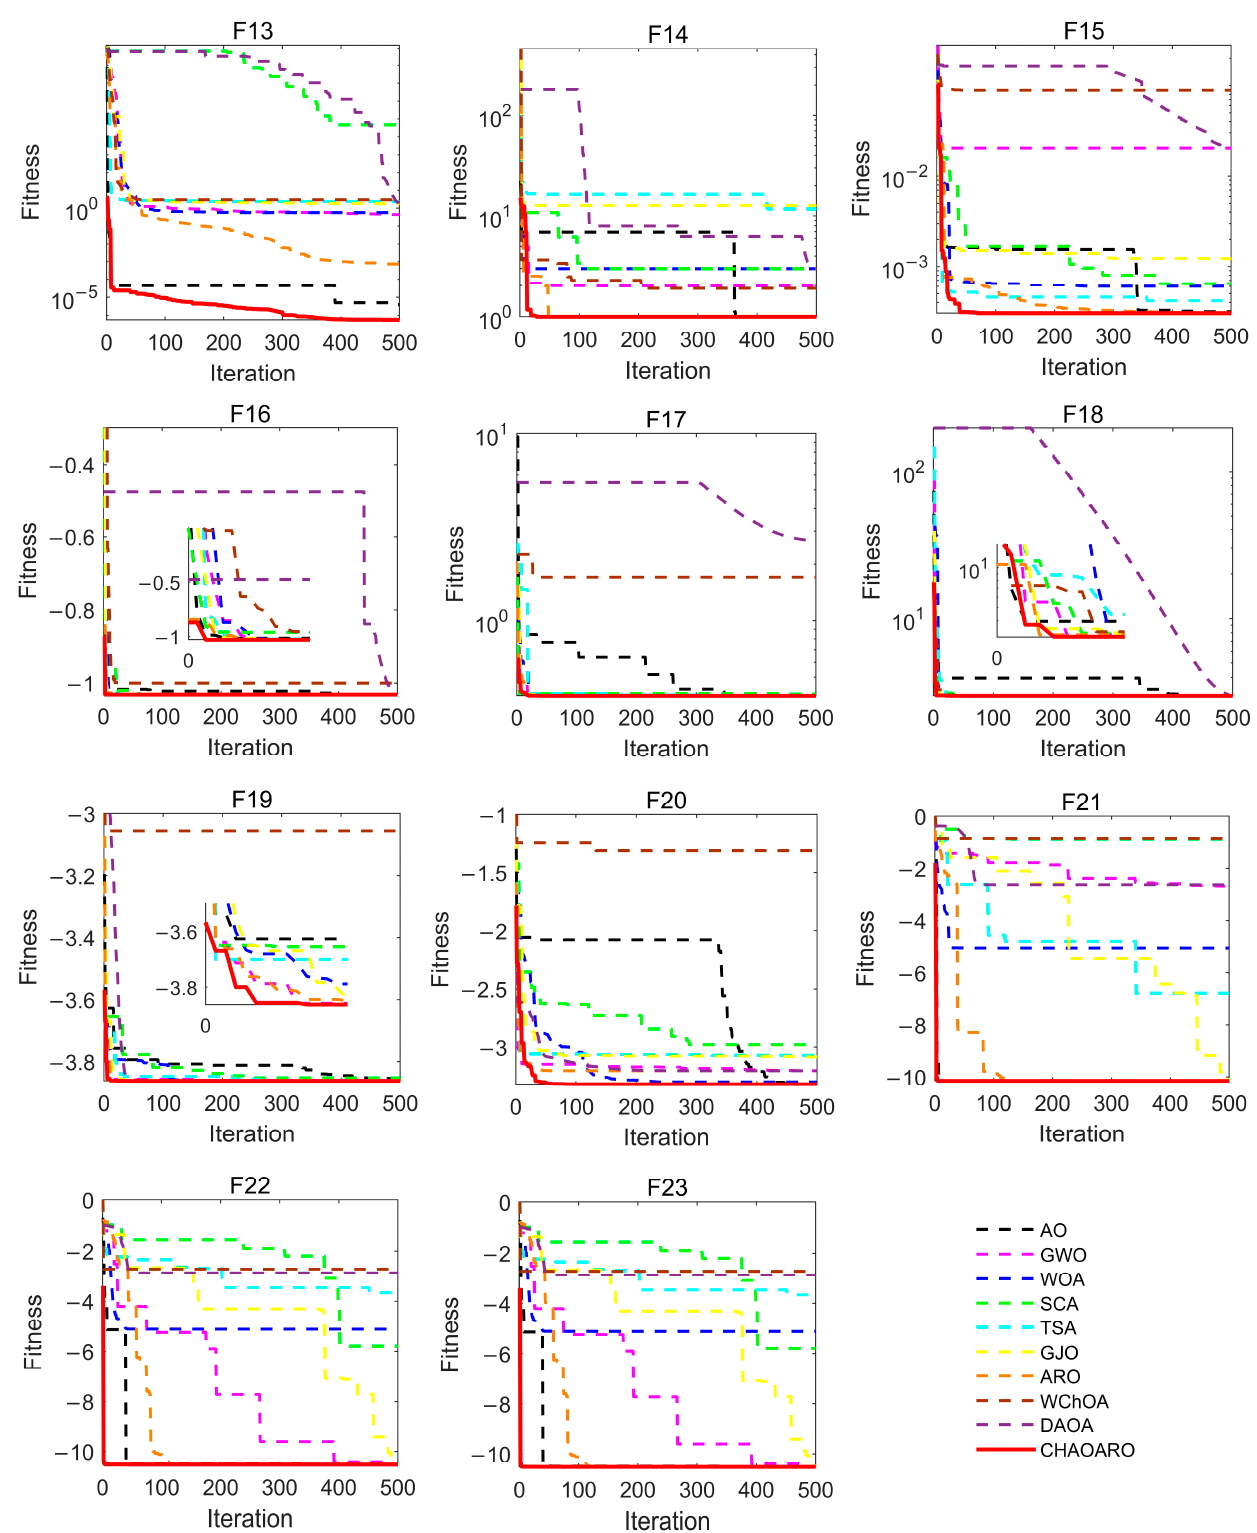
Figure 7. Convergence curves of CHAOARO and other comparison algorithms on 23 benchmark functions.